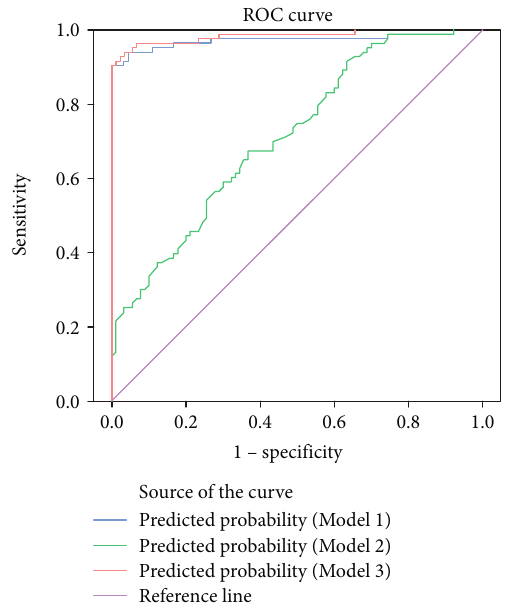
Figure 1: Receiver operating characteristic curve analysis for macroangiopathy prediction with three di ff erent models. Model 1 included traditional macrovascular risk factors such as age, sex, cigarette smoking, body mass index (BMI), HbA C, systolic blood 1 pressure (SBP), triglycerides (TG), high-density lipoprotein cholesterol (HDL-C), and low-density lipoprotein cholesterol (LDL-C). Area under the curve (AUC) of Model 1: 0.972, 95% CI: 0.943 ~ 1.000, P < 0 : 001 . Model 2 included only adiponectin. AUC of Model 2: 0.714, 95% CI: 0.639 ~ 0.789, P < 0 : 001 . Model 3 incorporated Model 1 plus Model 2. AUC of Model 3: 0.984,